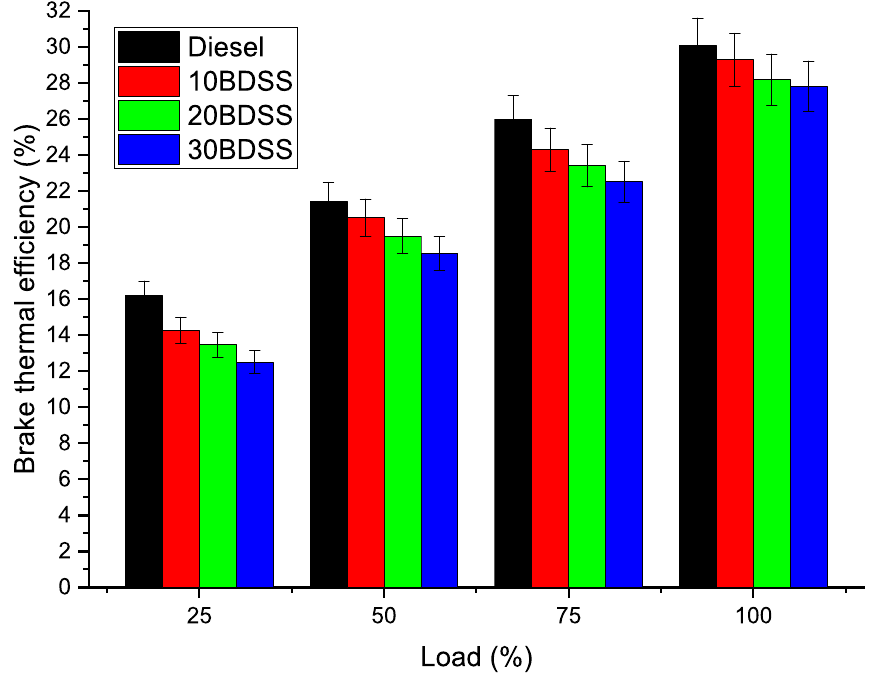
Figure 5. Influence of biodiesel blends in BTE (Brake thermal efficiency).